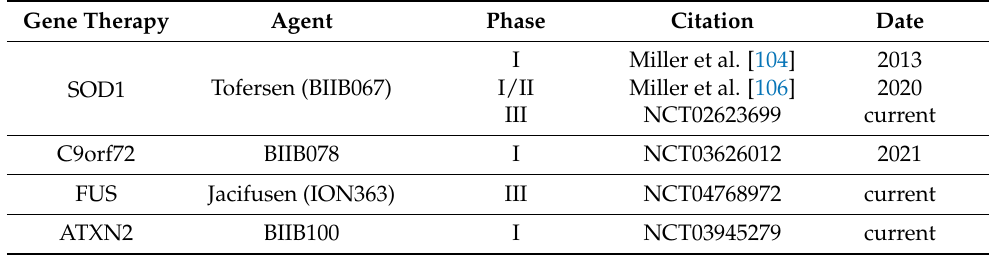
Table 2. Antisense oligonucleotides therapy Clinical Trials in Amyotrophic Lateral Sclerosis. Gene Therapy Agent